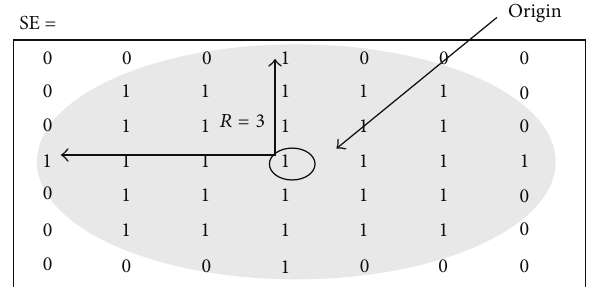
Figure 7: The structuring element with 𝑅 = 3 and 𝑁 = 4 “disk”